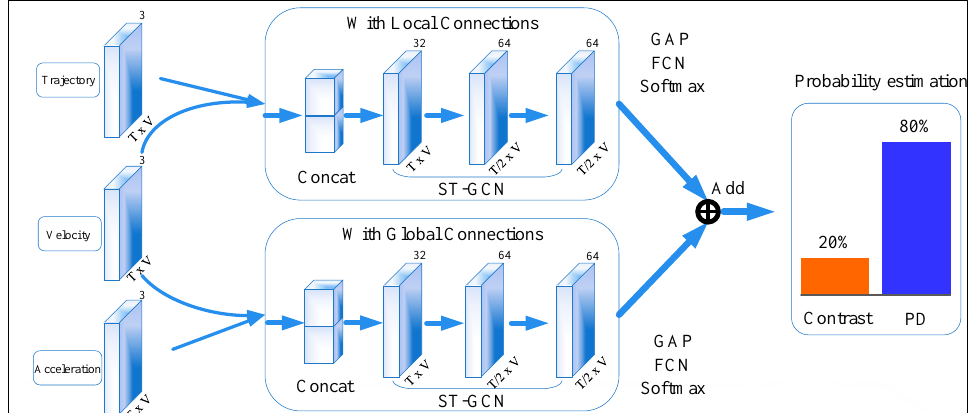
Figure 3. The dual branch network structure. The upper branch uses a local connection with input trajectory and velocity, while the lower branch uses a global connection with input velocity and